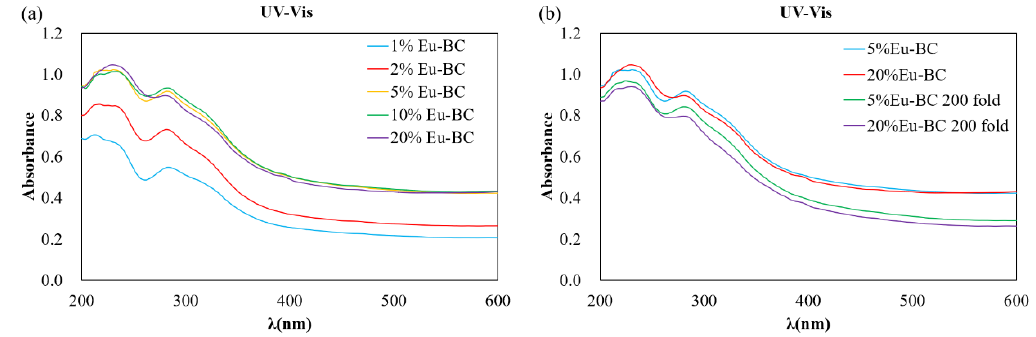
Figure 5. ( a ) UV-Vis absorbance spectra of fluorescent paper sheets with different Eu-BC contents and ( b ) changes in UV-Vis spectra after fluorescent paper was folded 200 times.